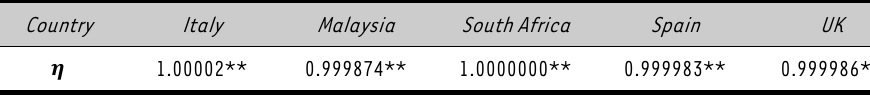
TABLE 11: Expenditure elasticities for USA tourists